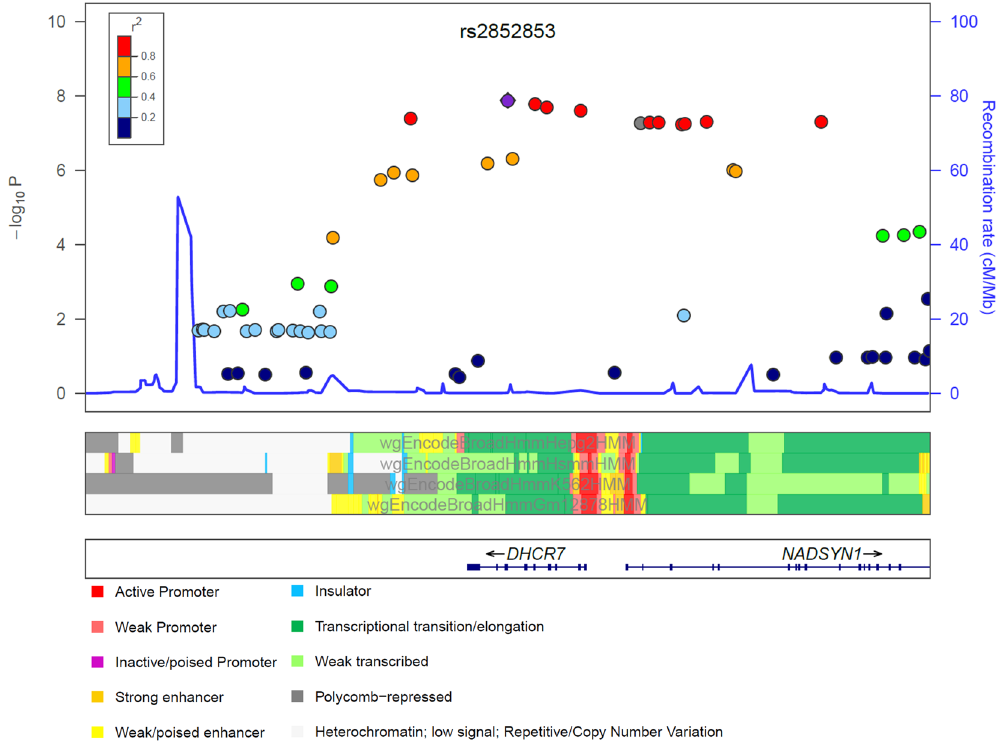
Figure 2. A regional view of DHCR7 -integrated vGWAS results with ENCODE regulatory